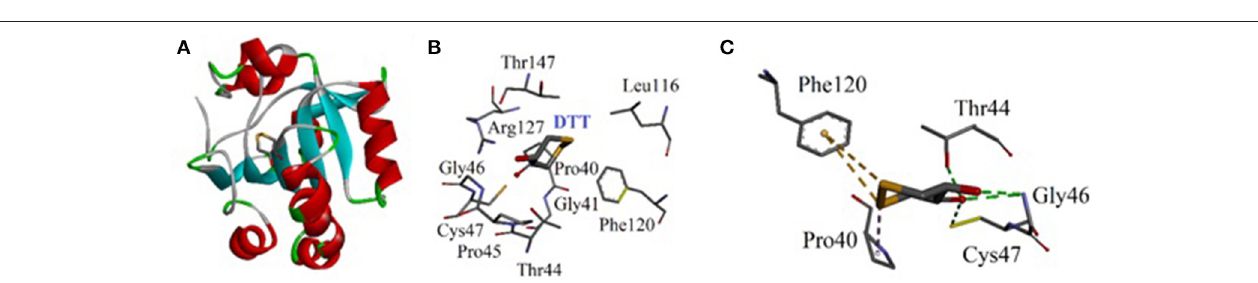
FIGURE 8 | (A) Computer generated structure ofhuman PrxV (PDB code 3MNG) with a competitive antioxidant inhibitor 1,2-dithiane-4,5-diol (DTT) (ribbon form); (B) Active site of 3MNG; (C) Interactions of DTT with important residues.